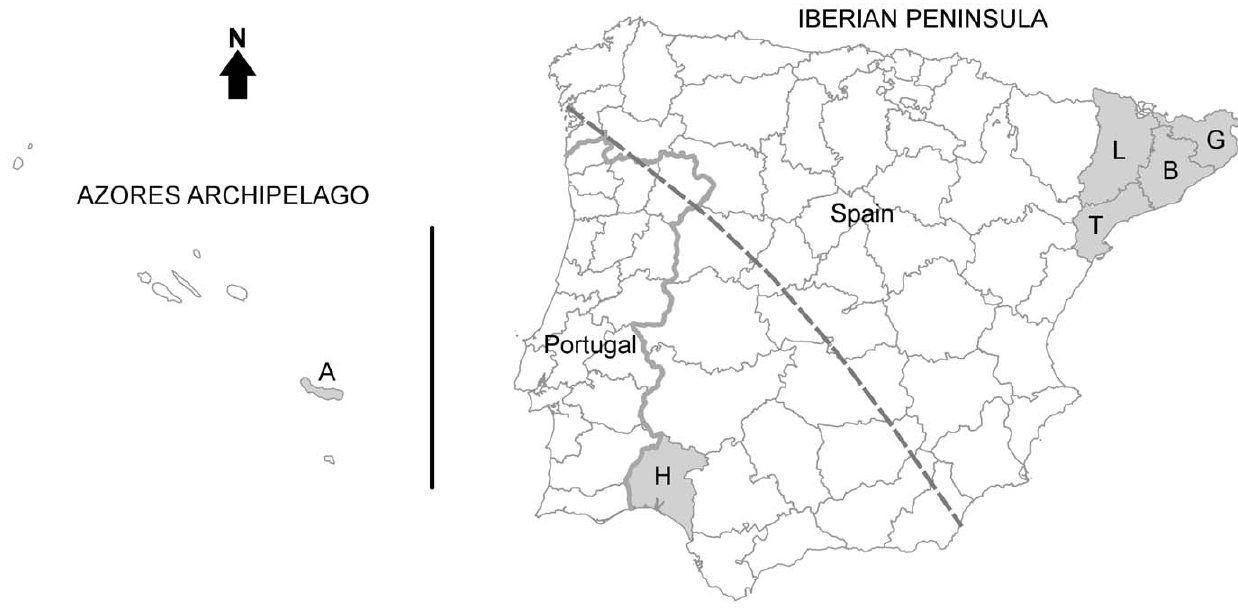
Figure 1. Geographic distribution of the analysed Taeniapisiformis individuals. Iberian Peninsula, the Azores archipelago and (shaded in grey) the regions of origin of the analysed sequences. Province initials correspond with those in Table 1. The dashed line is the putative limit between the north-eastern and south-western Iberian rabbit (intermediate host) lineages [13].